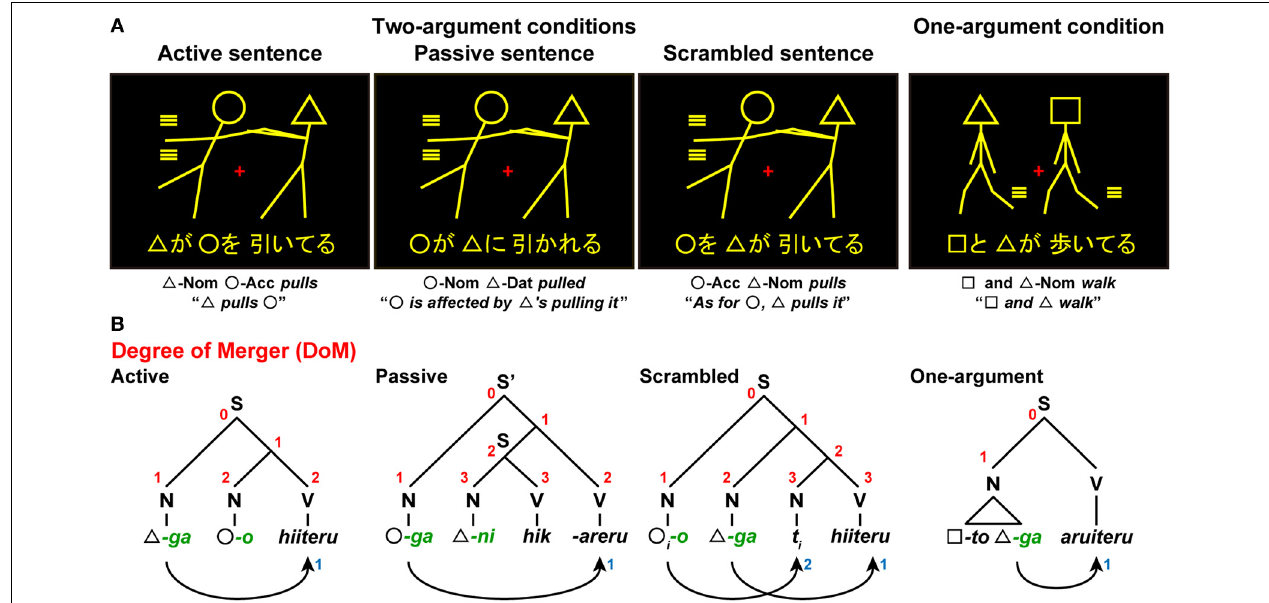
FIGURE 6 | A picture-sentence matching paradigm in Kinno et al. (2008). (A) A picture-sentence matching task under either Two-argument conditions or a One-argument condition. Each stimulus consisted of one picture (top) and one sentence (bottom). Below each example, word-by-word and full translations in English are shown. An identical picture set was used under the Two-argument conditions, where we tested three sentence types: active sentences (“ (cid:2) -ga ◦ -o hiiteru ”), passive sentences (“ ◦ -ga (cid:2) -ni hik-areru ”), and scrambled sentences